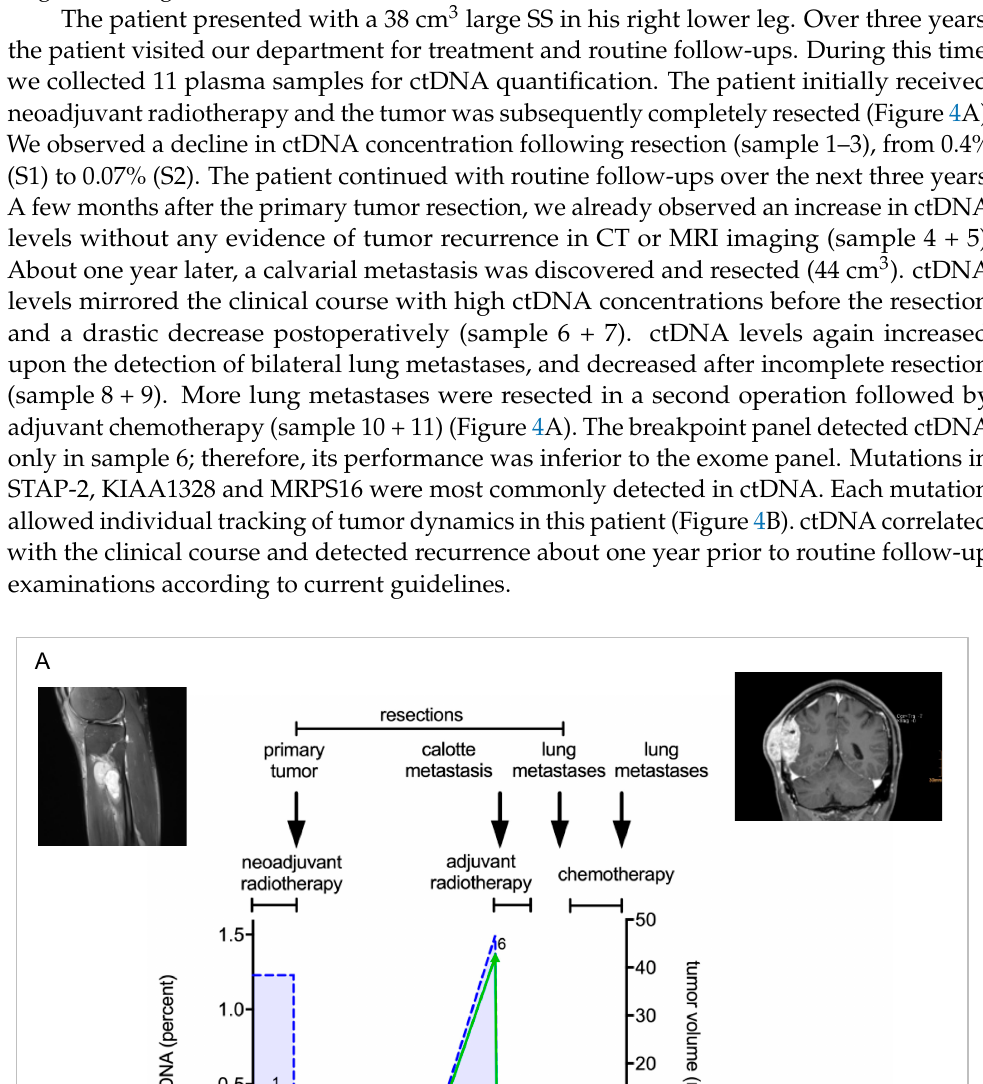
Figure 4. ctDNA quantification with a patient-specific panel derived from tumor exome sequencing. ( A ). Patient 6 was diagnosed with a synovial sarcoma in the right lower leg. He received neoadjuvant radiotherapy and the tumor was subsequently resected. He later developed a calvarial metastasis, which was resected, and additionally he developed metastases in both lungs, which were resected in parts. A patient-specific panel was designed from tumor exome sequencing to analyze the patient’s plasma samples. Eleven plasma samples were collected over the course of three years and analyzed with the patient-specific panel and breakpoint panel. The first sample analyzed (time point 1) was taken after radiotherapy, before resection of the primary tumor. Two plasma samples (sample 3 + 4) were taken in the two weeks following resection and a further eight samples in the following two years. ctDNA quantified by the patient-specific panel declined after resection of the primary tumor. An increase in ctDNA levels (sample 4) was detected one year prior to the detection of the calvarial metastasis. ctDNA again decreased after tumor resection and consequently increased with the occurrence of lung metastasis (red line). The breakpoint panel detected ctDNA only in the sixth time point just before resection of the calvarial metastasis (green line). The patient- specific panel is shown to be more sensitive than the breakpoint panel and is correlated with the clinical course. ( B ). Point mutations were identified in several genes, such as STAP2 , KIAA1328 and MRPS16 . ctDNA declined following resection of the primary tumor and increased one year prior to detection of the calvarial metastasis.